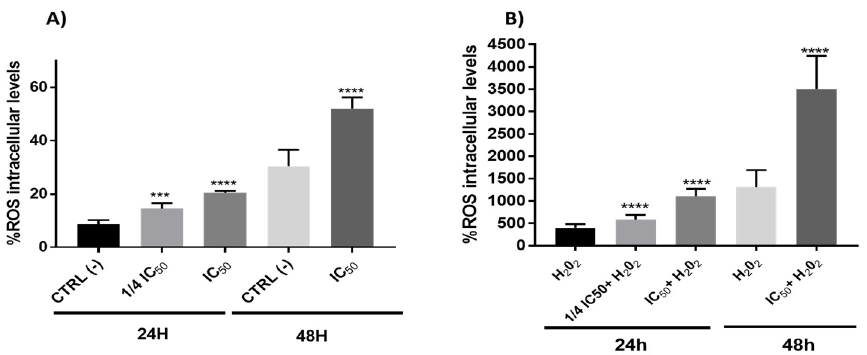
Figure 6. Measurements of ROS levels on Caco-2 cells in absence ( A ) or presence ( B ) of H 2 O 2 (80 mM, 20 min) after 24 or 48 h incubation with onion extract at IC 50 (1000 µg/mL) or ¼ IC 50 (250 µg/mL). *** p < 0.001; **** p < 0.0001 vs. CTRL (left) or H 2 O 2 (right).